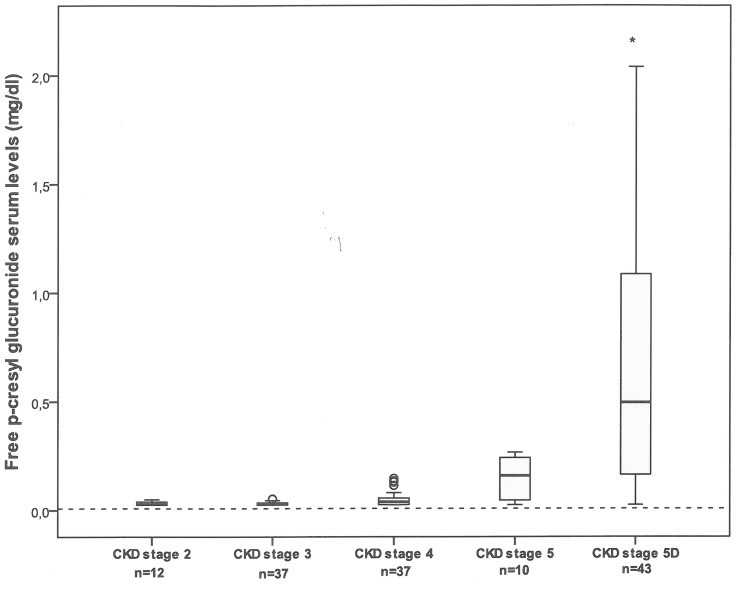
Serum levels of free p-cresylglucuronide as a function of CKD stage 2, 3, 4, 5 and 5D.*p<0.0001. The dotted line indicates the reference value for healthy subjects (0.035±0.003 mg/dL).